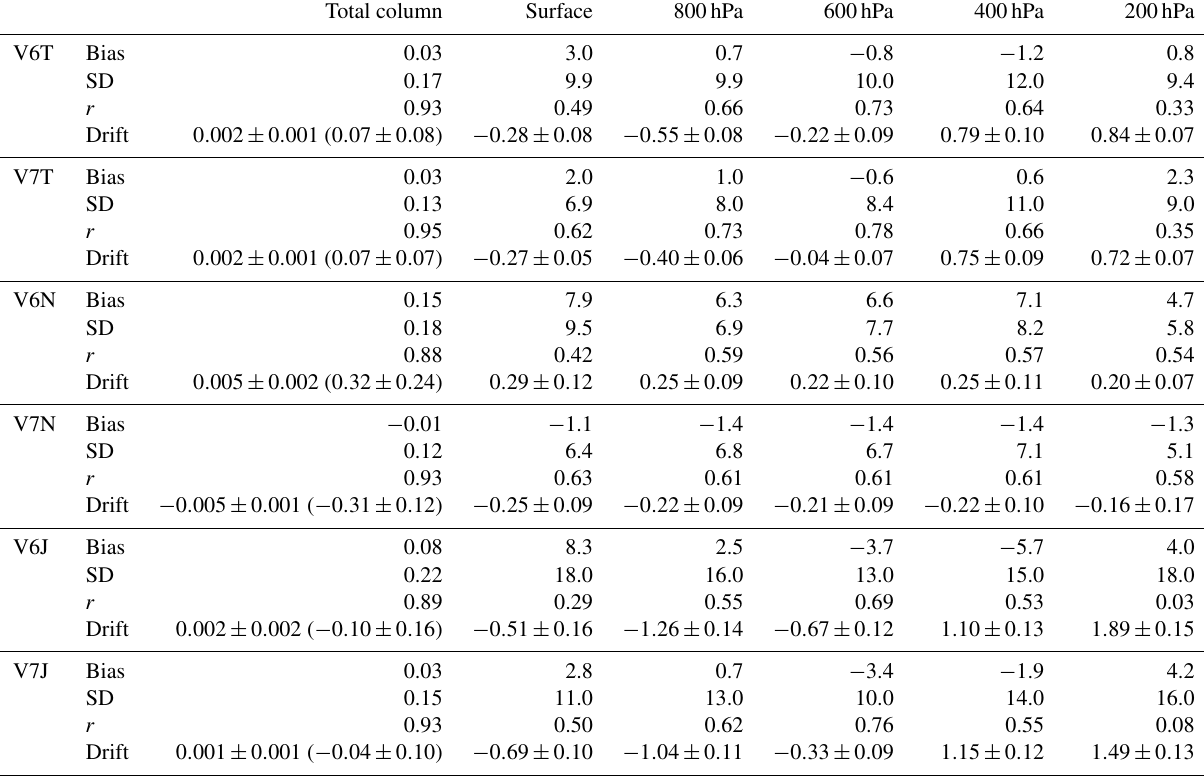
Table 1. Summarized validation results for V6 and V7 TIR-only (V6T and V7T), NIR-only (V6N and V7N) and TIR-NIR (V6J and V7J) products based on in situ data from NOAA validation sites. Bias and standard deviation statistics for the total column are in units of 10 18 moleccm − 2 . Bias and standard deviations for retrieval levels are expressed as percentages. Correlation coefficients ( r ) for profile levels are based on differences between retrieved quantities and corresponding a priori quantities, as described in Sect. 3.1. Total column drift values are provided in units of both 10 18 moleccm − 2 yr − 1 and %yr − 1 (in parentheses). Drift for the retrieval levels is expressed in units of %yr − 1